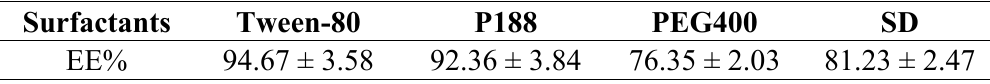
Table 1. Screening of surfactants between Tween-80, Poloxamer 188 (P188), PEG400, Sodium Deoxycholate (SD) ( ± s, n = 3). x